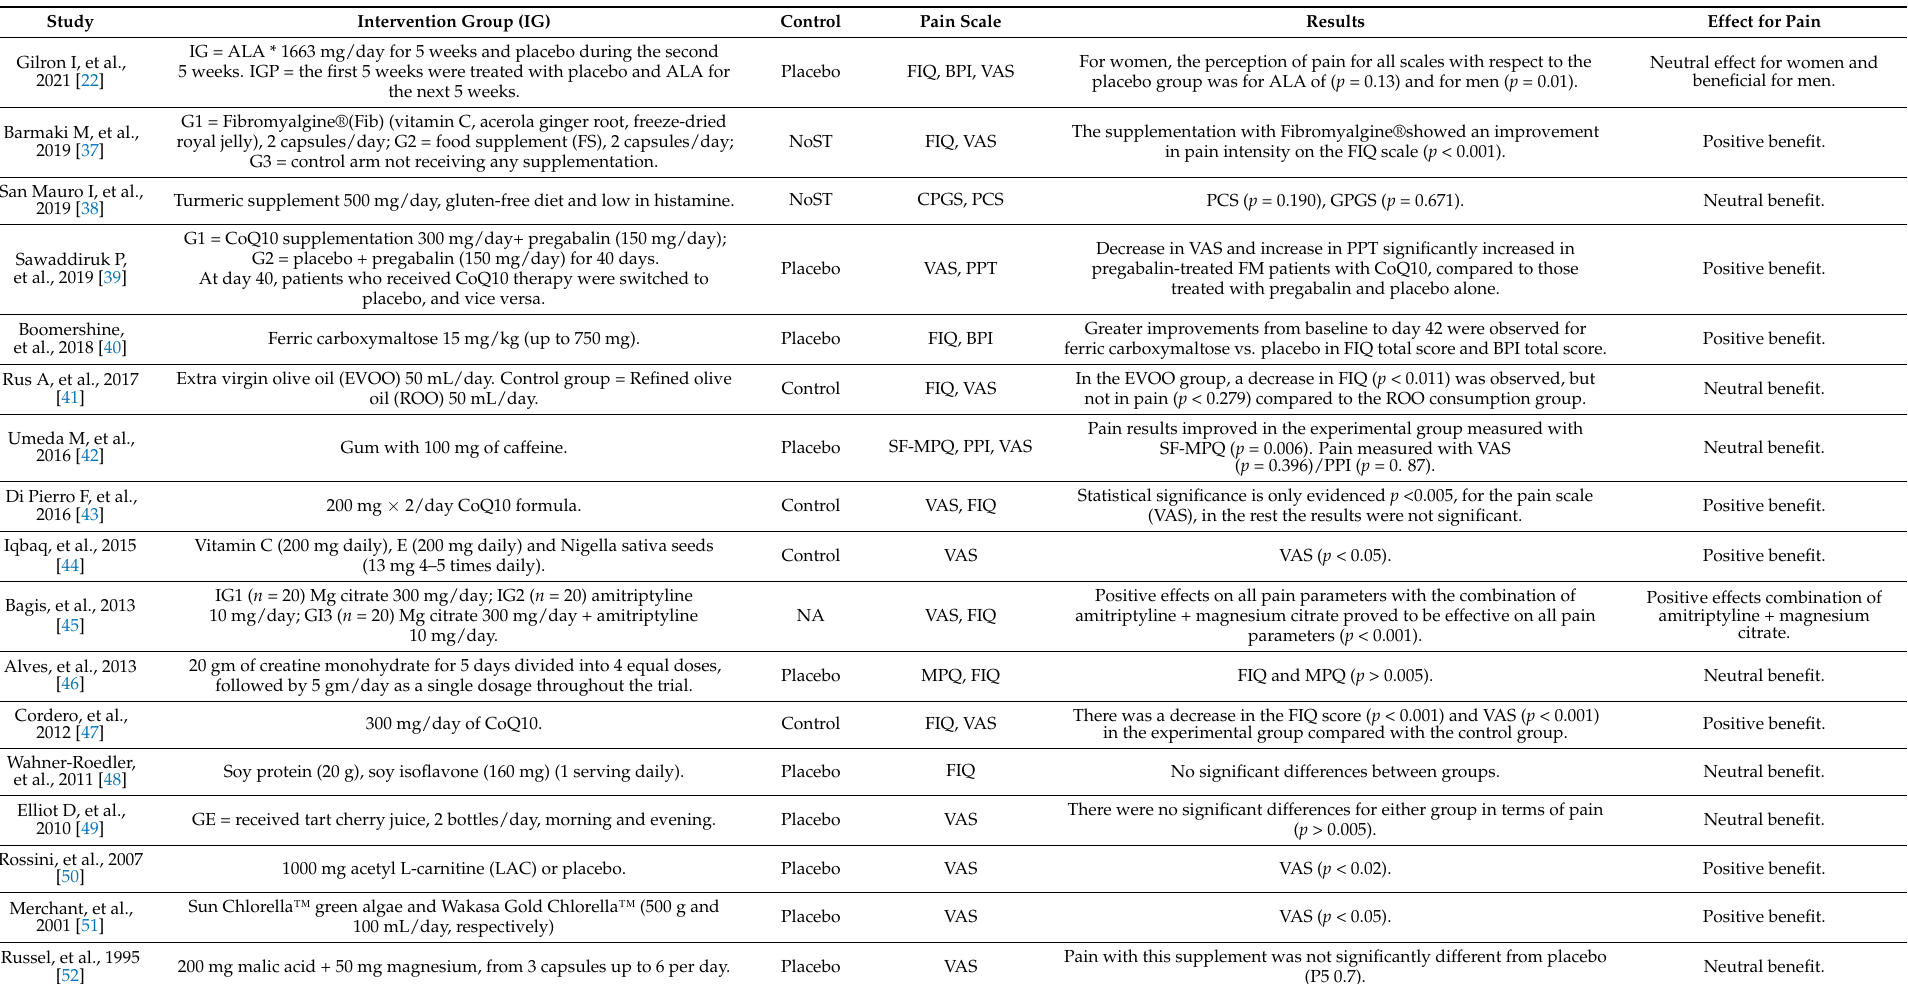
Table 3. Synthesis of the studies included in the systematic review with types of supplementation and doses and instruments for measuring